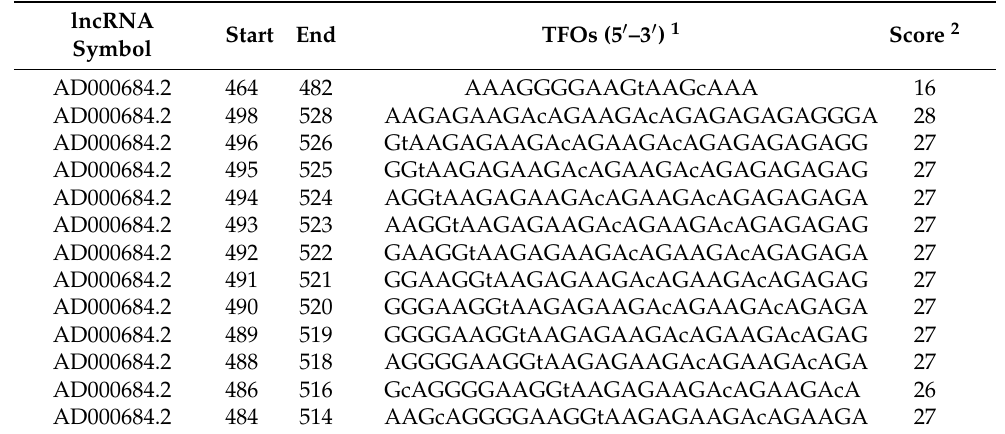
Table 4. TFOs predicted by Triplexator.